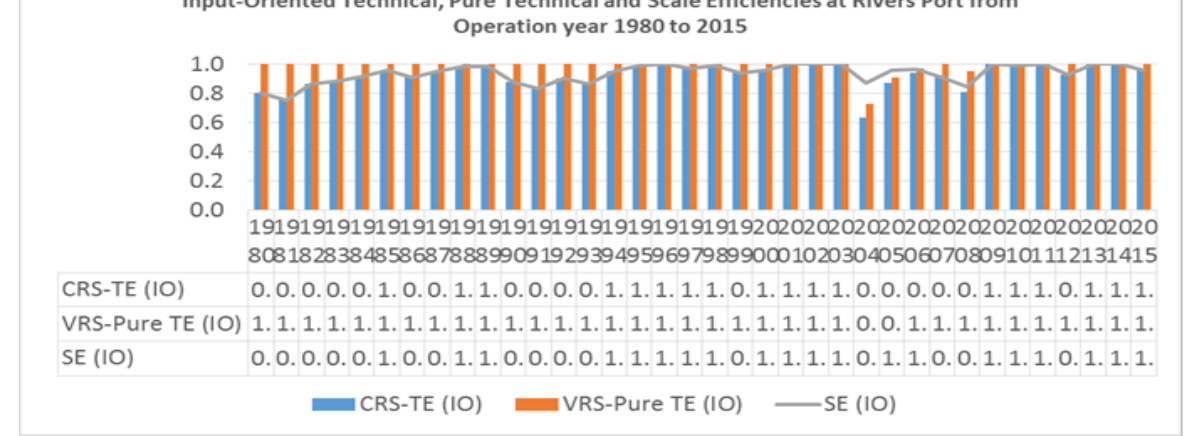
Figure 5: CRS – Technical Efficiency (Input-oriented) and CRS – Scale Efficiency (Input-oriented) at Rivers Port Complex from 1980 – 2015